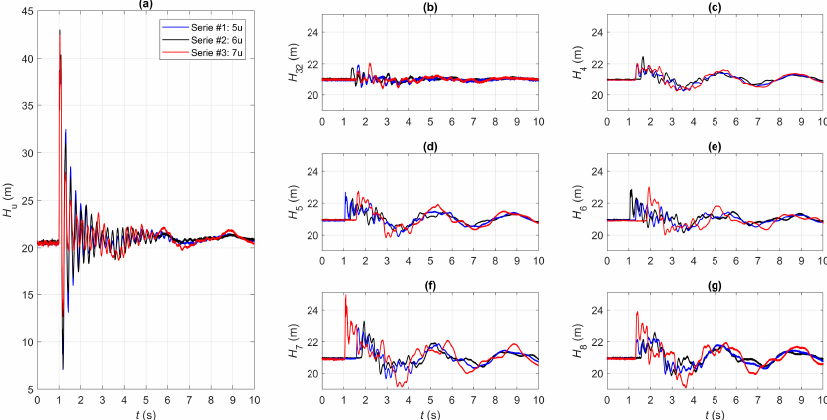
Figure 6. Pressure signals acquired during tests #1 (blue lines), #2 (black lines), and #3 (red lines) with Q 0,5 u = Q 0,6 u = Q 0,7 u = 0.12 L/s at measurement sections: ( a ) end-user (5u/6u/7u); ( b ) 32; ( c ) 4; ( d ) 5; ( e ) 6; ( f ) 7; and ( g )